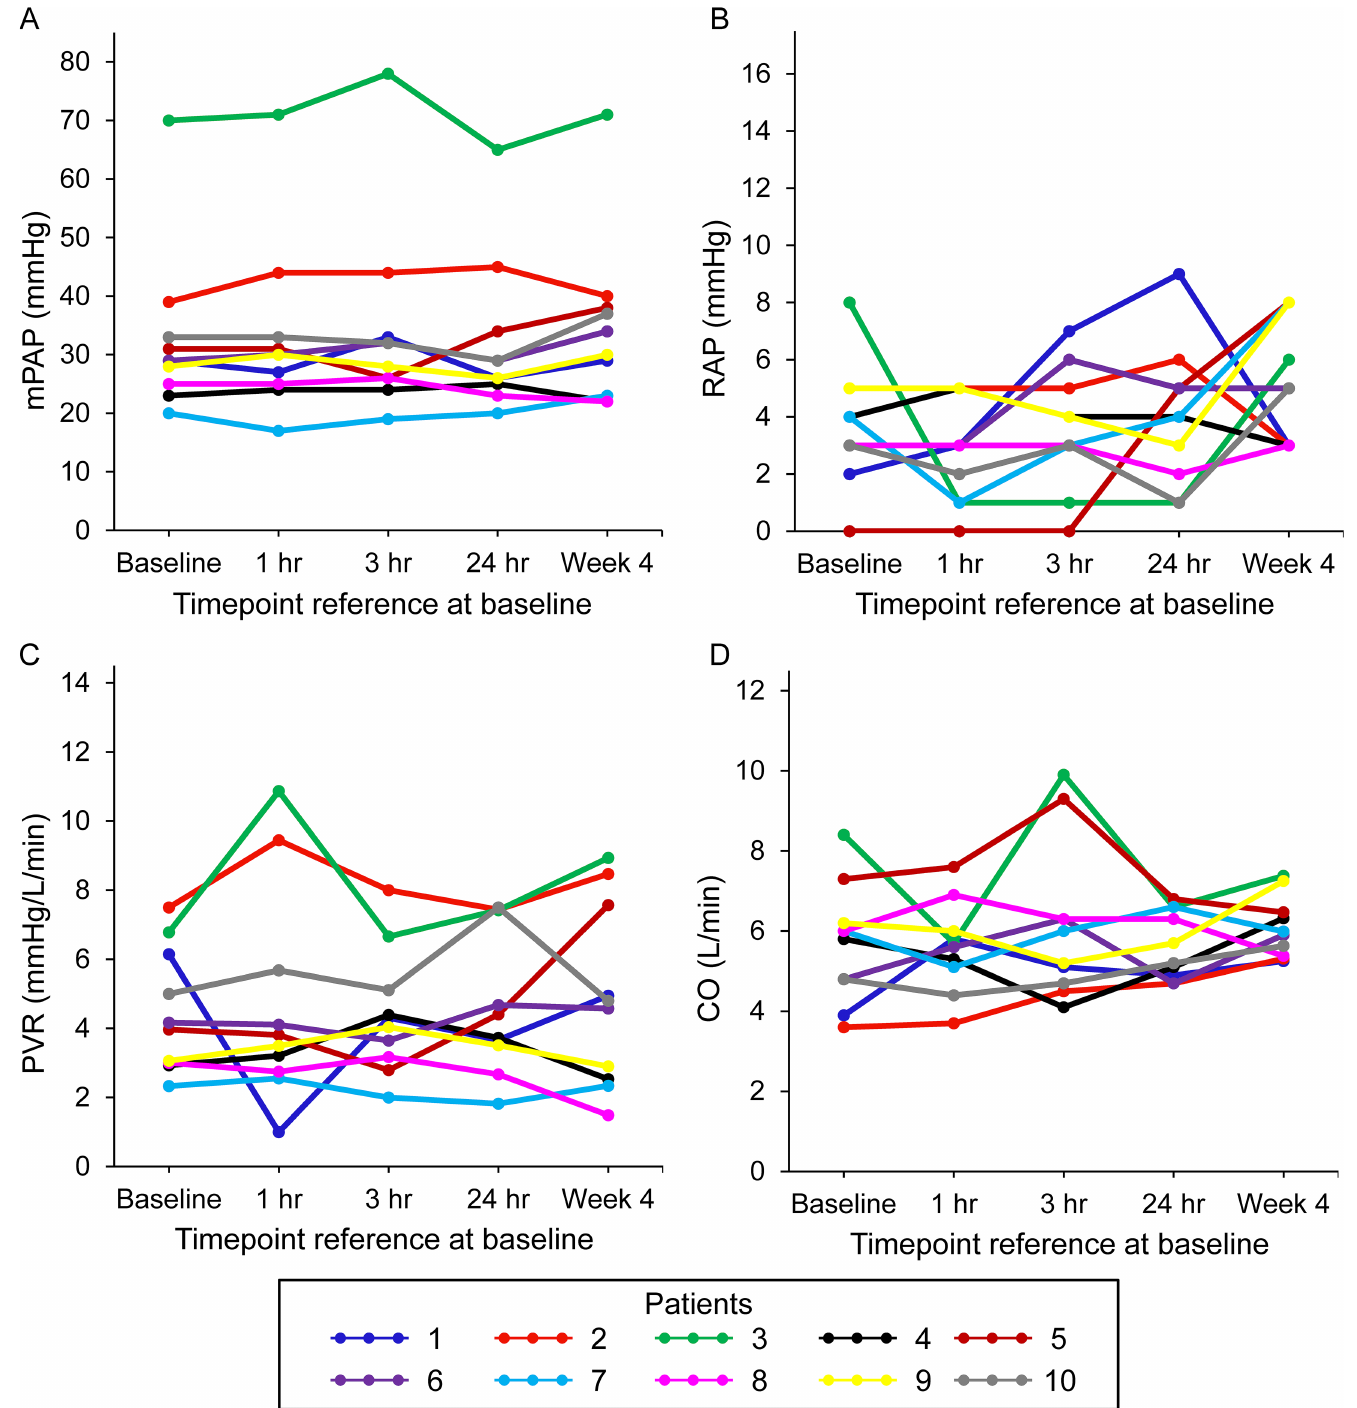
Fig 2. Changes from baseline in mPAP, RAP, PVR, and CO after switching in individual patients (n = 10). mPAP: mean pulmonary artery pressure, RAP: right atrial pressure, PVR: pulmonary vascular resistance, CO: cardiac output.